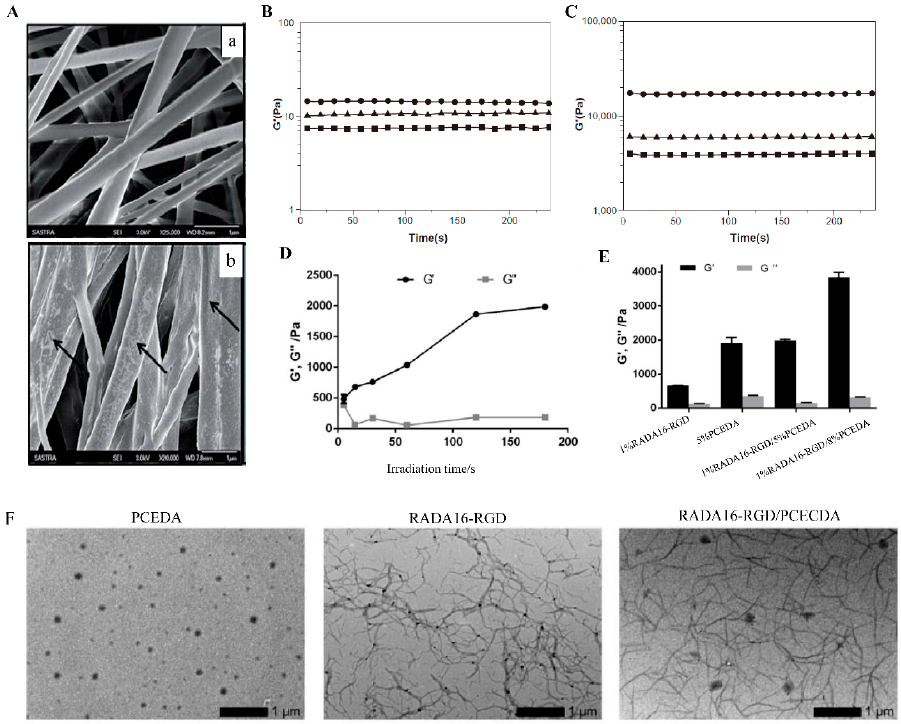
Figure 6. Modification of RADA16-Ifor mechanical performance. ( A ) SEM images of 200–300 nm PLGA nanofibers ( a ) and PLGA nanofibers coated with 1% peptide ( b ). Adapted with permission from Ref. [79]. Copyright 2015 RSC advances. ( B ) The storage modulus of RADA16-I, R3, and R4 in aqueous solutions. ( C ) The storage modulus of RADA16-I, R3, and R4 after they have formed hy-